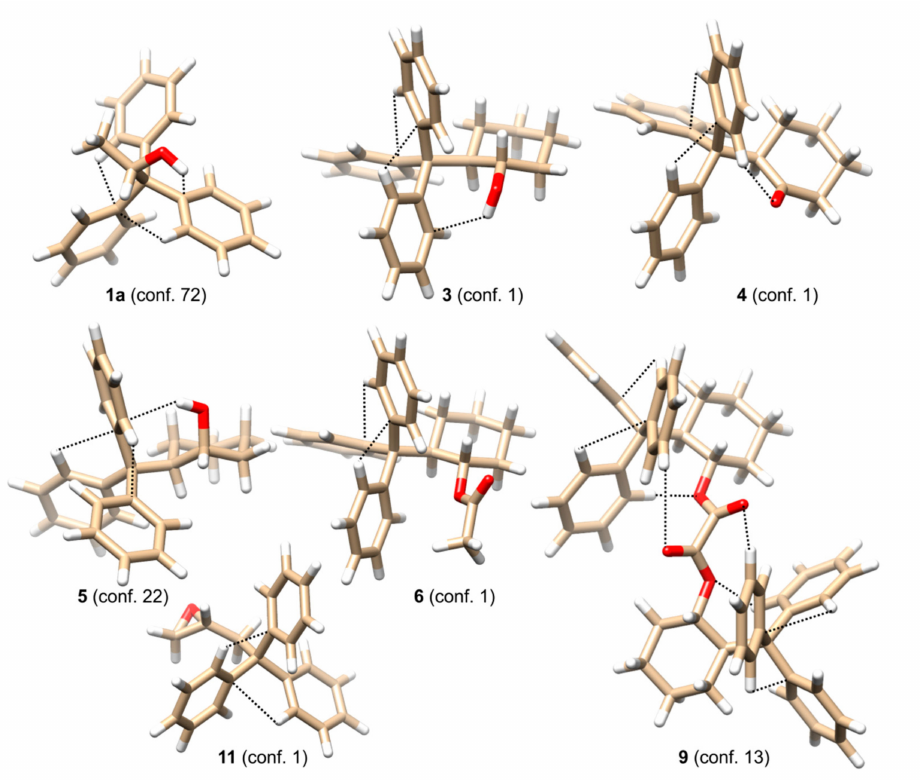
Figure 2. The structures of the lowest energy conformers of 1a , 3 – 6 , 9 , and 11 calculated at the B3LYP / 6-311 ++ G(d,p) or B3LYP / 6-311G(d,p) (compound 9 ) level of theory. The dashed lines indicate possible attractive interactions (the remaining structures are deposited as Supplementary Information). Table 2. The ∆∆ G -based percentage populations (Pop.) and helicities of trityl chromophore calculated for the lowest energy conformers of 1a – 1e , 3 – 9, and 11 at the B3LYP / 6-311 ++ G(d,p) level of theory. Compound a Pop.